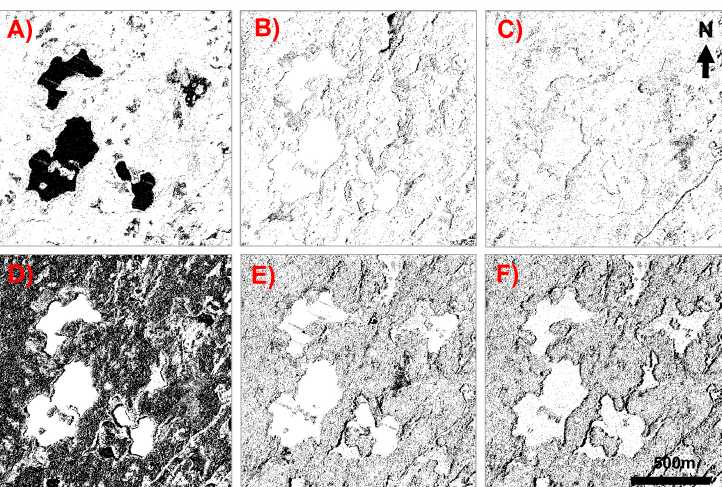
Figure 13. Five outcomes from the decision tree classifier and the LiDAR only additional statement showing the spatial extent of the sensor agreement from 3 September 2016. Black pixels represent areas where outcome occurred, white pixels represent areas where outcome did not occur: ( A ) All agree; ( B ) All disagree; ( C ) SAR disagree; ( D ) Optical disagree; ( E ) LiDAR disagree; and ( F ) LiDAR only.